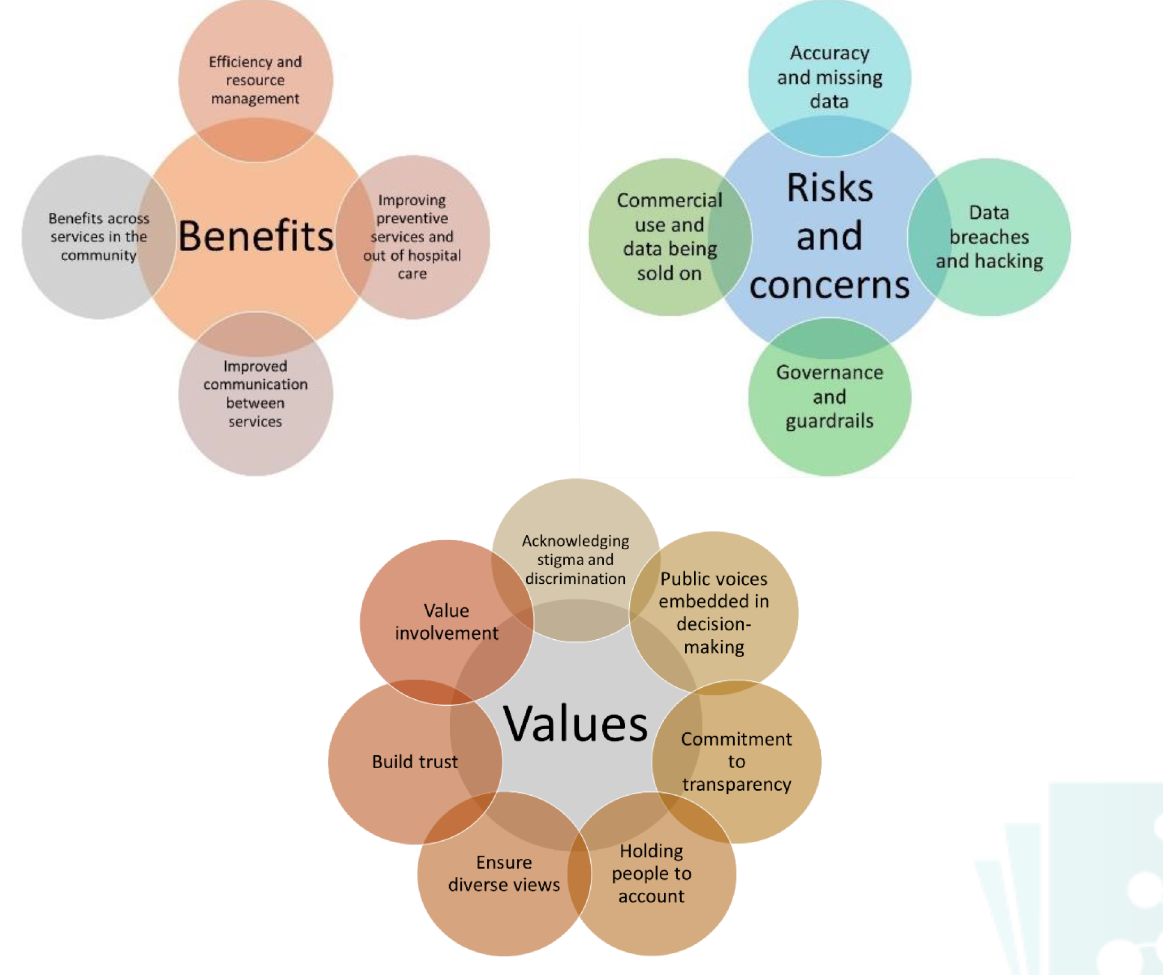
Figure 2: Depiction of themes across the 3 topics covered in the focus